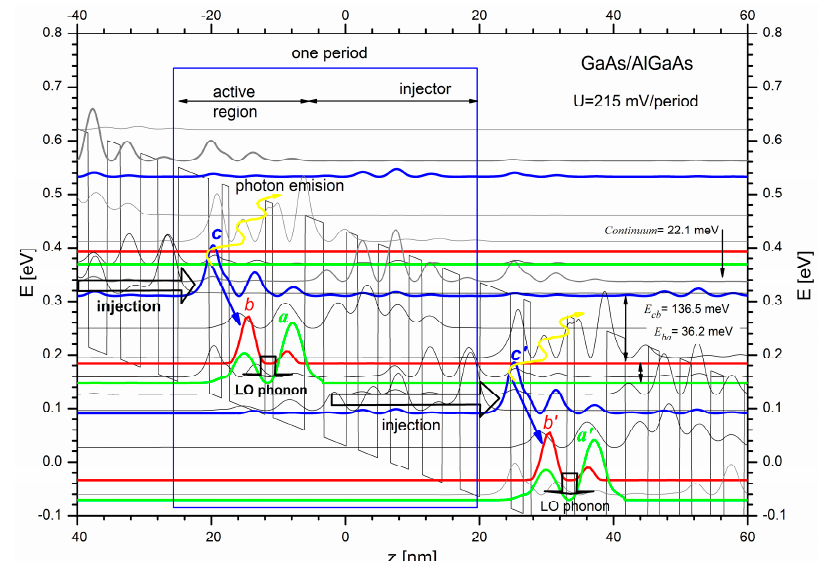
Figure 1. Illustration of the basic mechanisms for the QCL. The electrons tunnel from the relaxation (injection) region of the previous structure period to the high state ( c ) of the next superlattice period, followed by a transition to the medium state ( b ) with a photon emission. In the next step, the electron goes to the low state ( a ) by emitting a phonon and due to the electric field, it is further transported through the injection area to the high state of the next period ( c’ ), where the sequence of transitions between states is repeated. Namely, we observe the photon transition between states ( c’ ) and ( b’ ) and then the emission of the phonon after the electron transition from state ( b’ ) to ( a’ ).